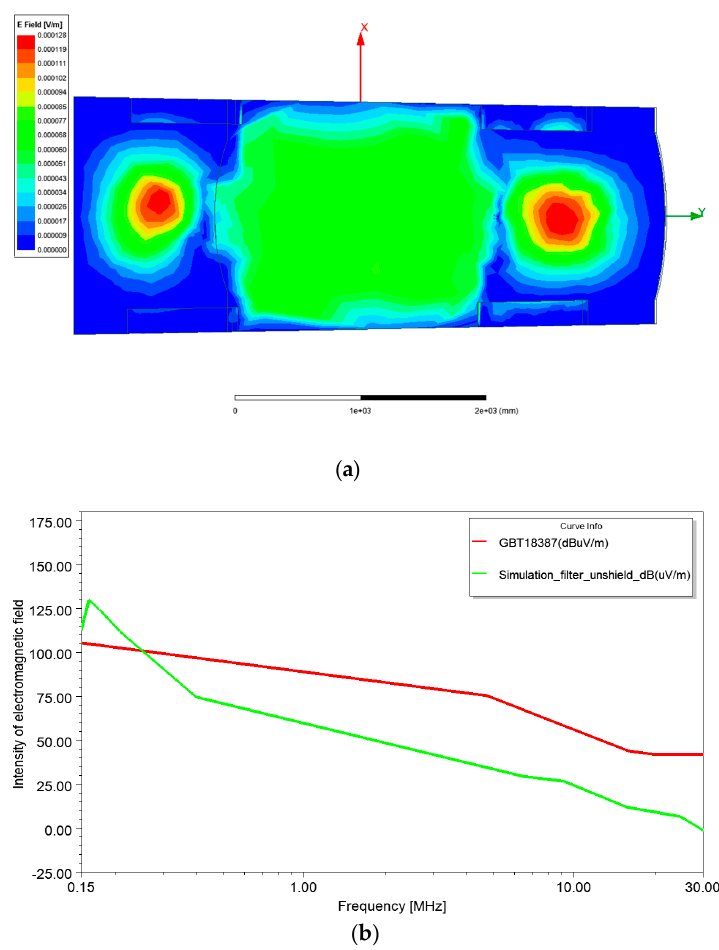
Figure 10. ( a ) Distribution of electromagnetic field; ( b ) electric field intensity at 3 m. As can be seen from Figure 10, compared with the EMF intensity of the vehicle with- out the filter, the common-mode current and radiated emission are reduced significantly. However, the EMF still exceeds the standard at low frequency.